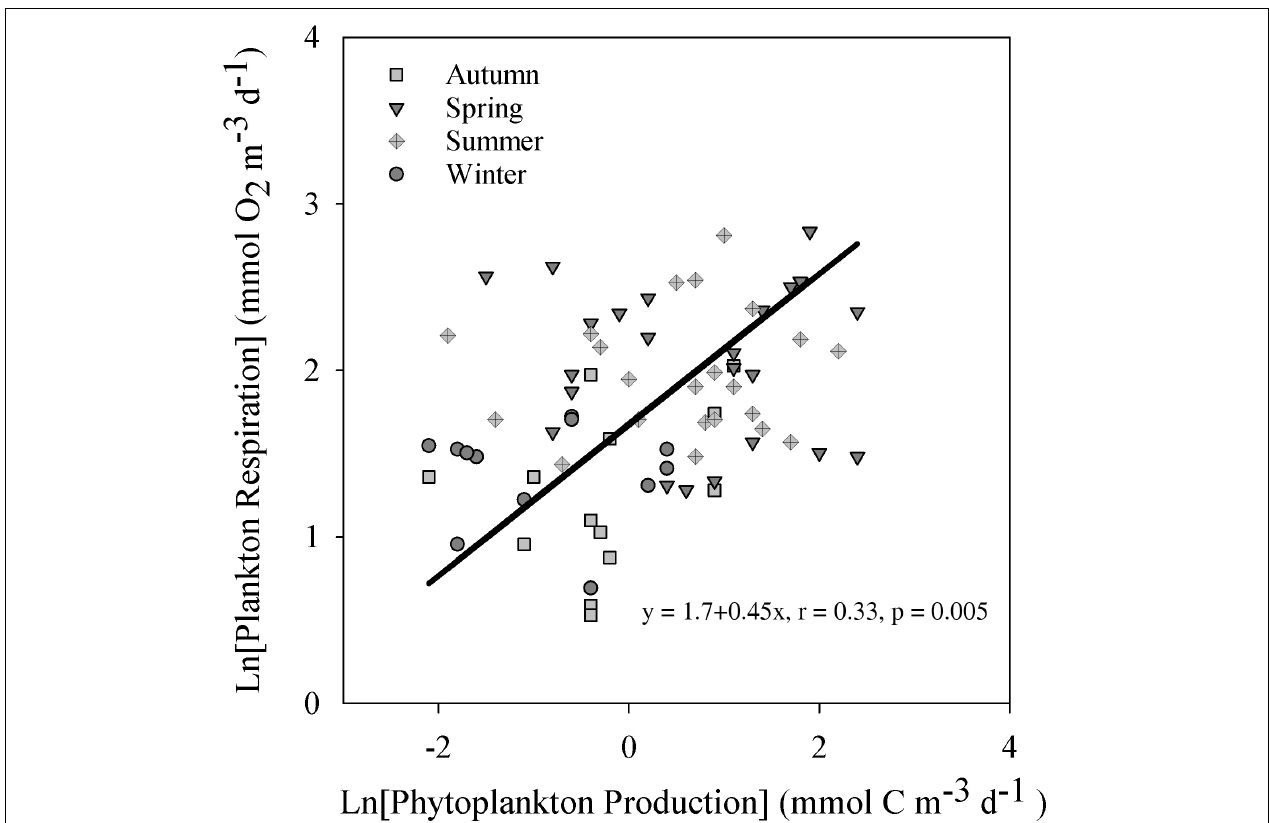
FIGURE 3 | Natural logarithm-transformed plankton respiration vs. the phytoplankton production categorized by season. Only cases above the calculated detection limits are included. The solid line show the fit by a model II regression. The figure include the resulting function and Pearson correlation coefficient with significance